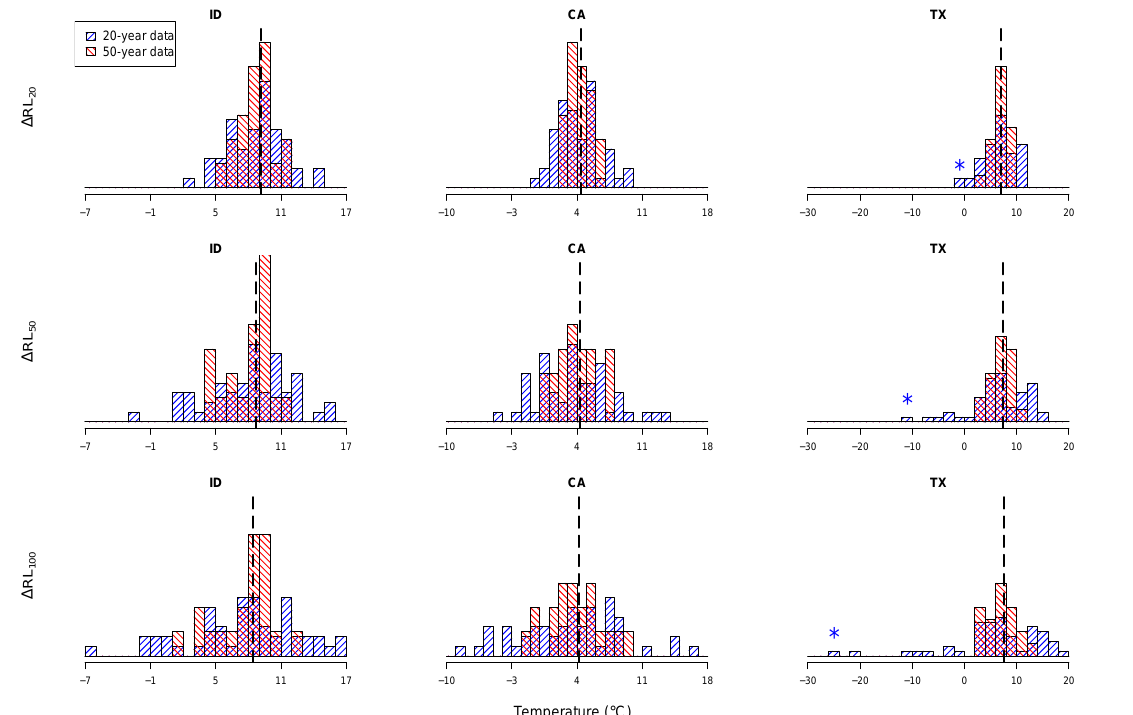
Figure 11. Same as Fig. 10 but for cold extremes. Pre-industrial return levels for these locations are ID: − 54.9, − 56.8, and − 57.8 ◦ C; CA: − 8.5, − 10.1, and − 11.2 ◦ C; and TX: − 17.2, − 19.9, and − 21.8 ◦ C. Especially unreliable estimates of changes in return levels were obtained for one pair of 20-year segments in TX (denoted by ∗ ). This error is mainly due to a poorly estimated shape parameter: for this pair of 20-year segments, the estimated shape increased from 0 . 10 to 0 . 60 (the estimates given by PWM are 0 . 12 and 0 . 11), while the “true” values (based on 1000-year runs) were − 0.10 and − 0.05 for the pre-industrial and 700ppm scenarios,